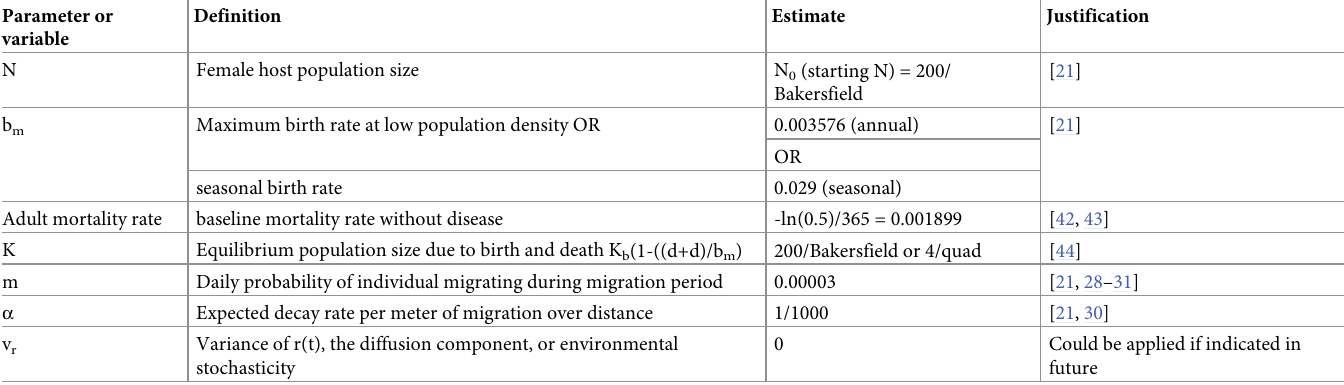
Table 2. Definition and estimates of kit fox population variables and parameters for model metaseir, a stochastic, discrete-time compartment and metapopulation model for mange and population dynamics, applied to San Joaquin kit foxes in Bakersfield, California. Parameter or variable